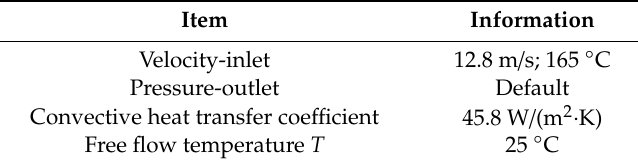
Table 2. Boundary conditions for the CFD analysis.